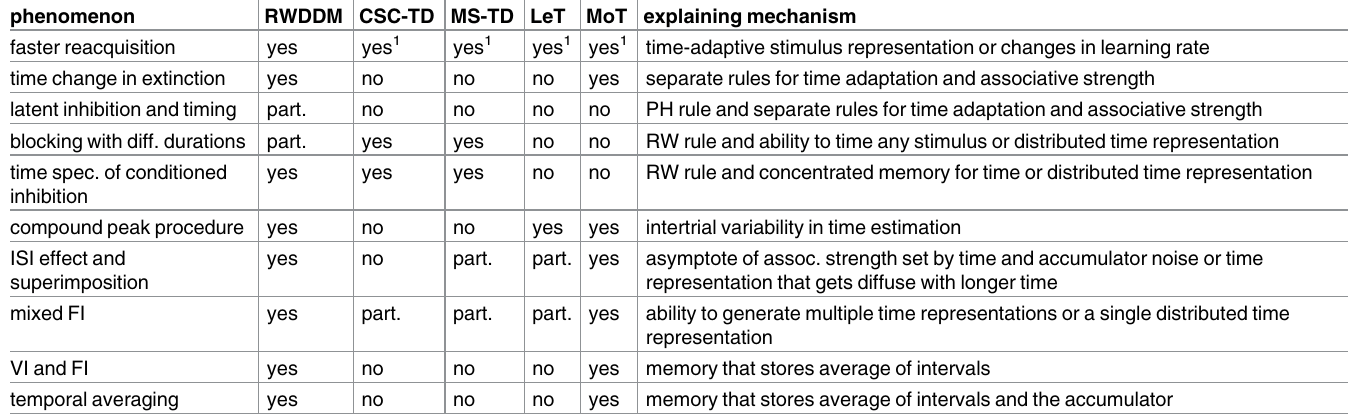
Table 4. Summaryof main simulation results and comparison with other models. Notes: (1) if learningrate is allowedto vary.